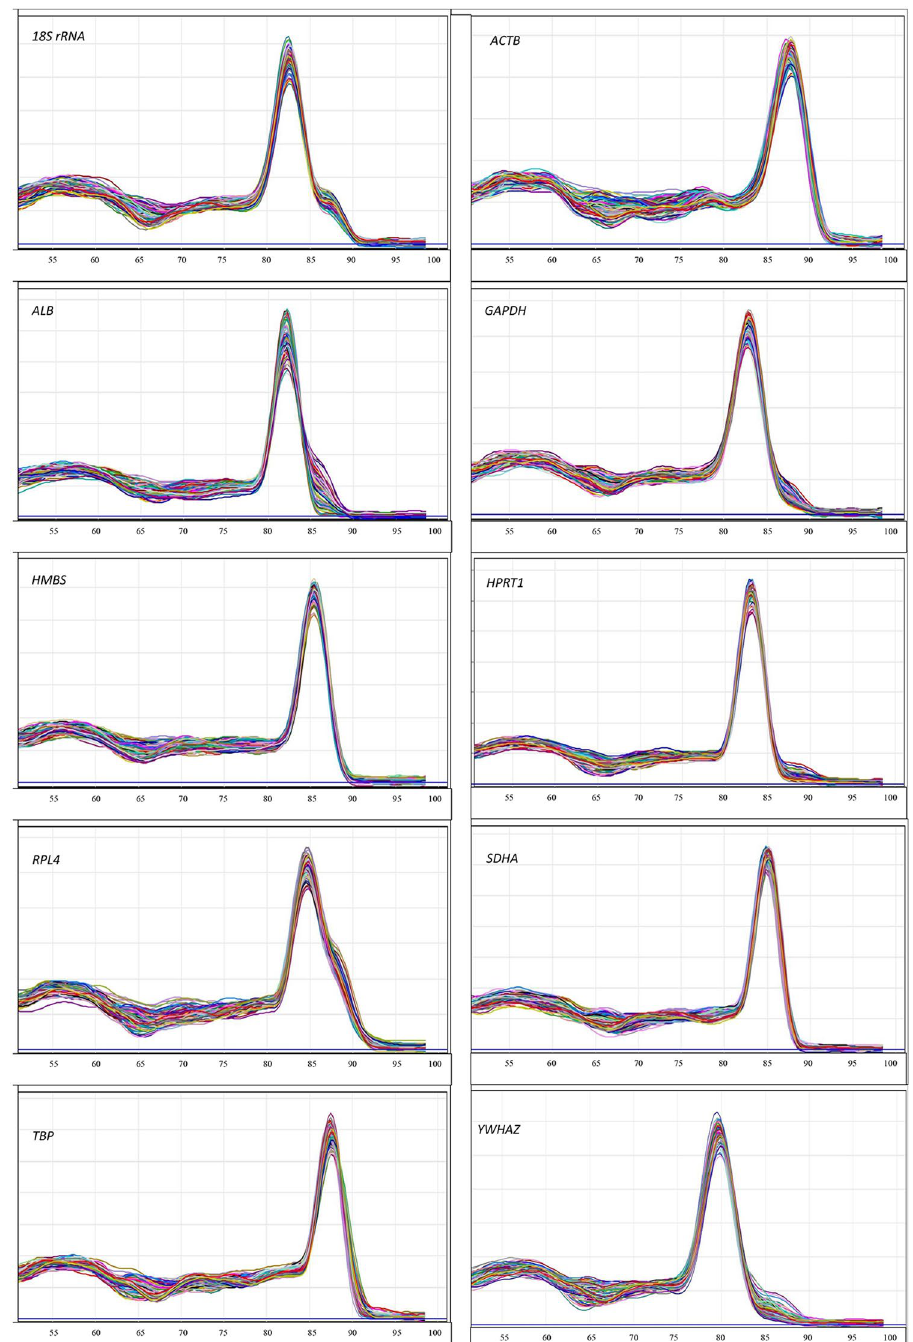
Figure 2. Melting curves of 10 reference genes in the shell gland samples. All melting curves showing a single peak indicated that all primers were specific in amplifying fragments of the genes and chances for primer dimers were minimum in the qPCR products. A melting phase at a ramp from 50 °C to 99 °C at 1 °C increments in Rotor-Gene Q was performed to assess the specificity of PCR